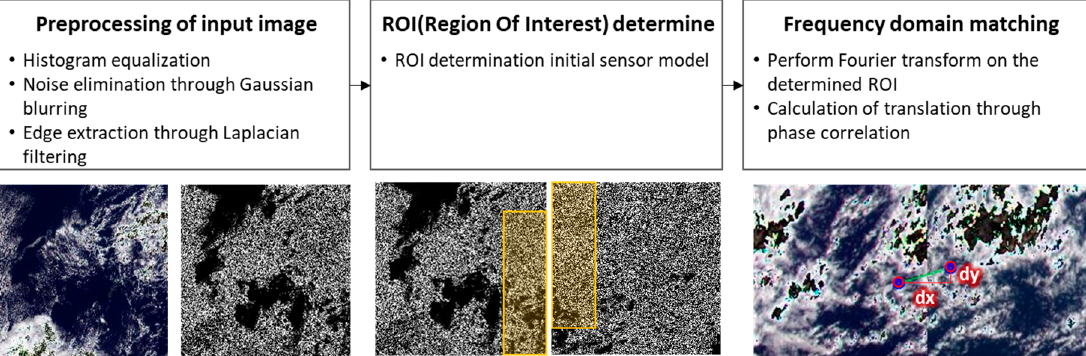
Figure 6. Process of frequency domain matching for GOCI slots.